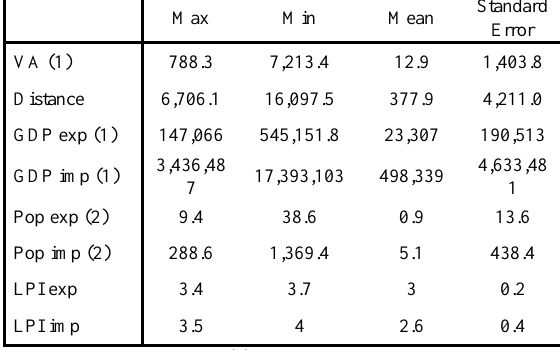
Table 5A: Main Statistics 2014 for Group